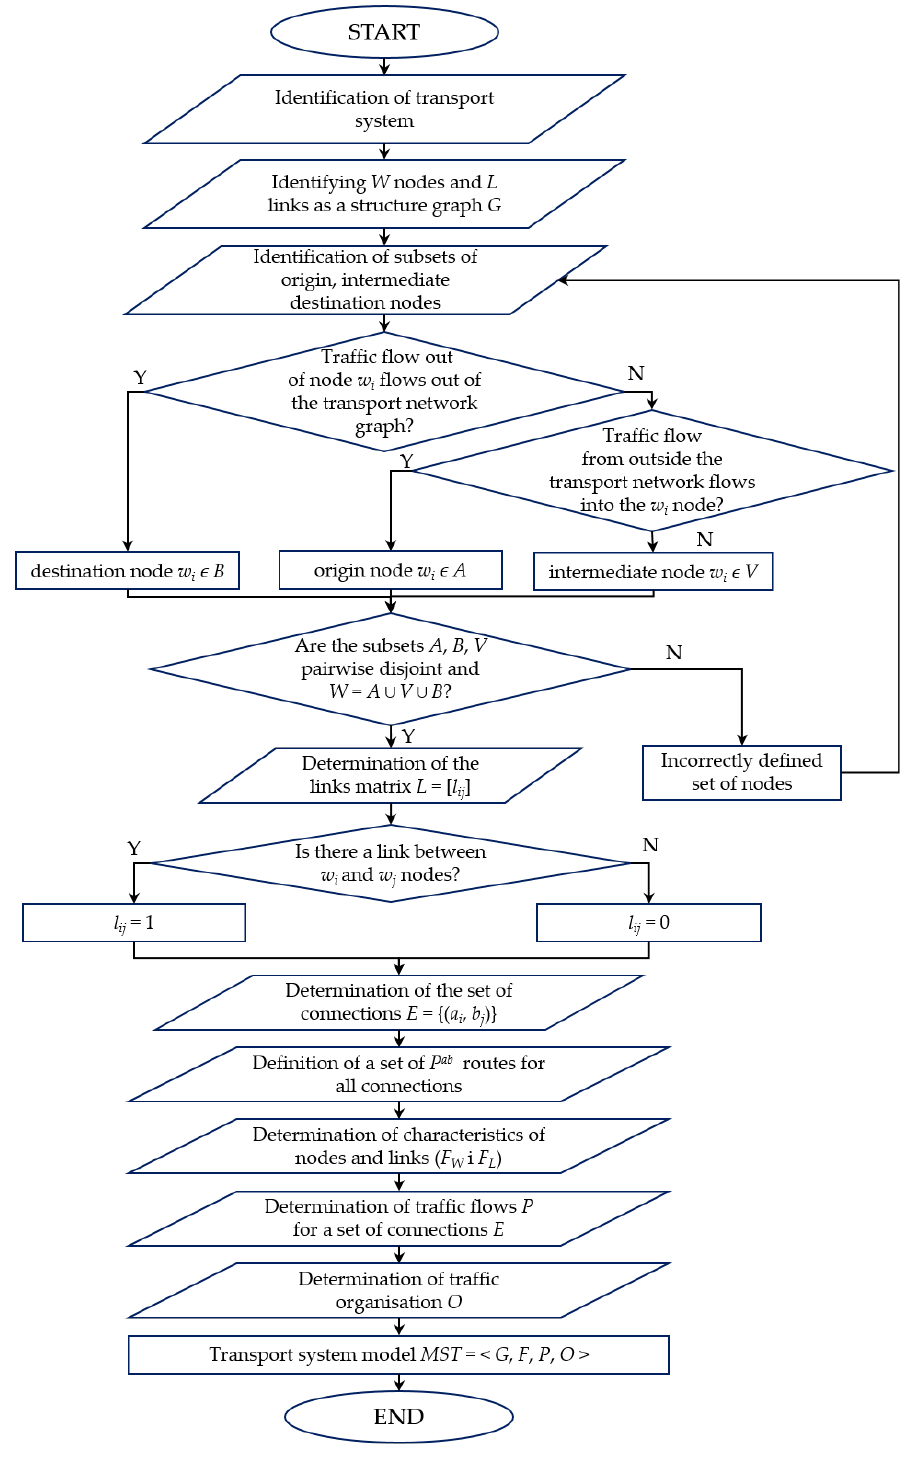
Figure 1. This is a figure. Schemes follow the same formatting. If there are multiple panels, they Figure 1. Transport system model creation algorithm